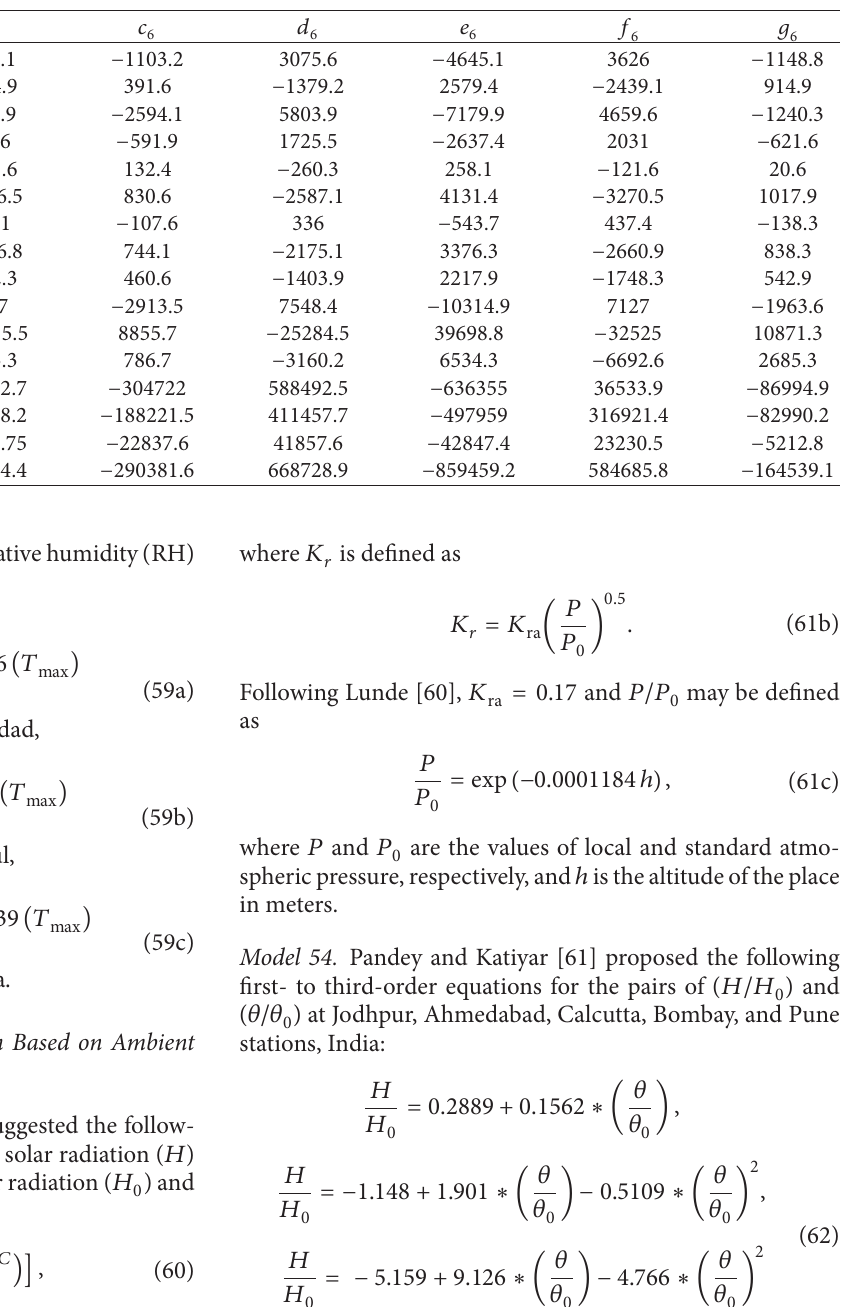
T 1: Regression coefficients of sixth order polynomial (57) for different cities of